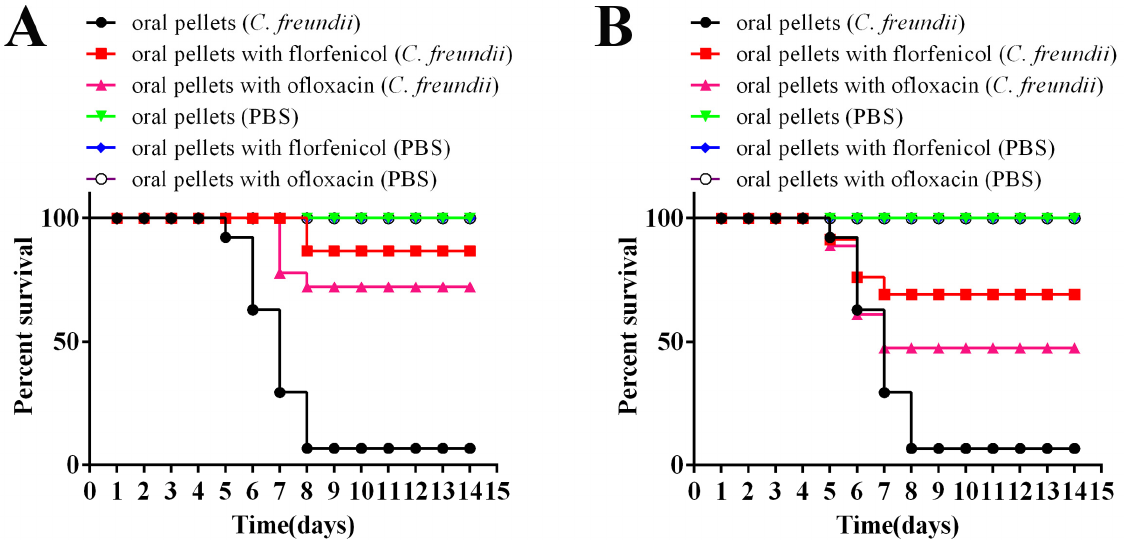
Figure 7. RPS of florfenicol and ofloxacin treatment at different time points after the challenge intramuscular with 100-fold LD 50 C. freundii strain GDZQ201912 for 14 days. ( A ) RPS of prawns treated with antibiotic pellets at the same time with C. freundii challenge. ( B ) RPS of prawns treated with antibiotic pellets after death occurred post C. freundii